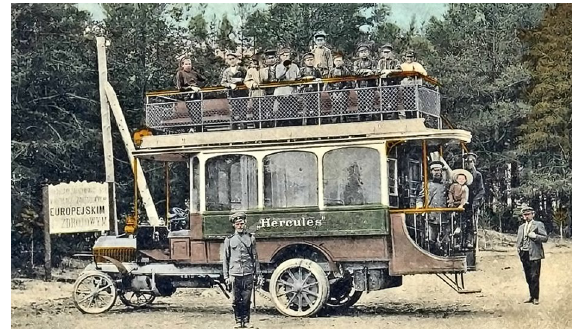
Fig. 9. One of the first buses in